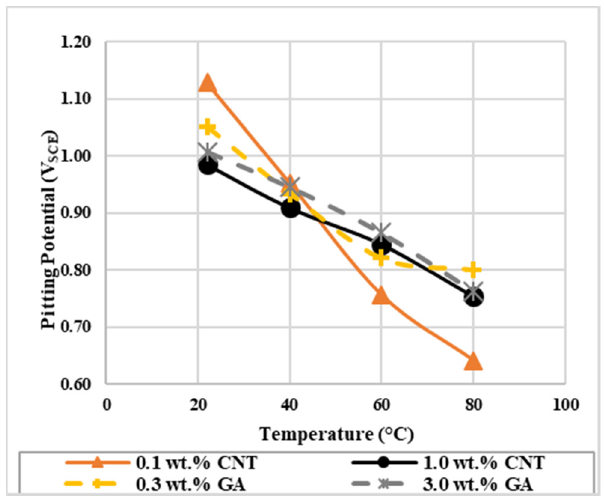
Figure 3. The effect of temperature on the pitting potential of 316L stainless steel exposed to CNTs– water nanofluids and GA-deionized water solutions of different concentrations.